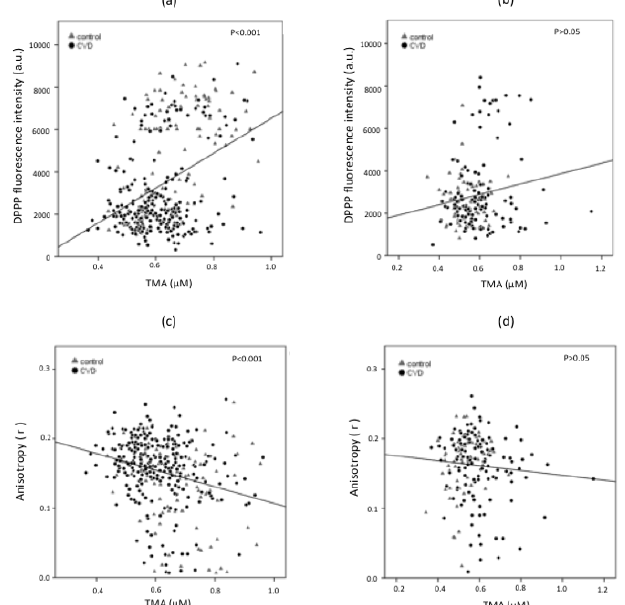
Figure 4. Correlations between plasma TMA levels and DPPP in males ( a ) or females ( b ), and DPH anisotropy (r), in the male ( c ) or female ( d ) groups. Only in the male group, erythrocyte membrane lipid hydroperoxide (DPPP fluorescence intensity, a.u.) correlates positively, and membrane fluidity (anisotropy, r) inversely with plasma TMA.